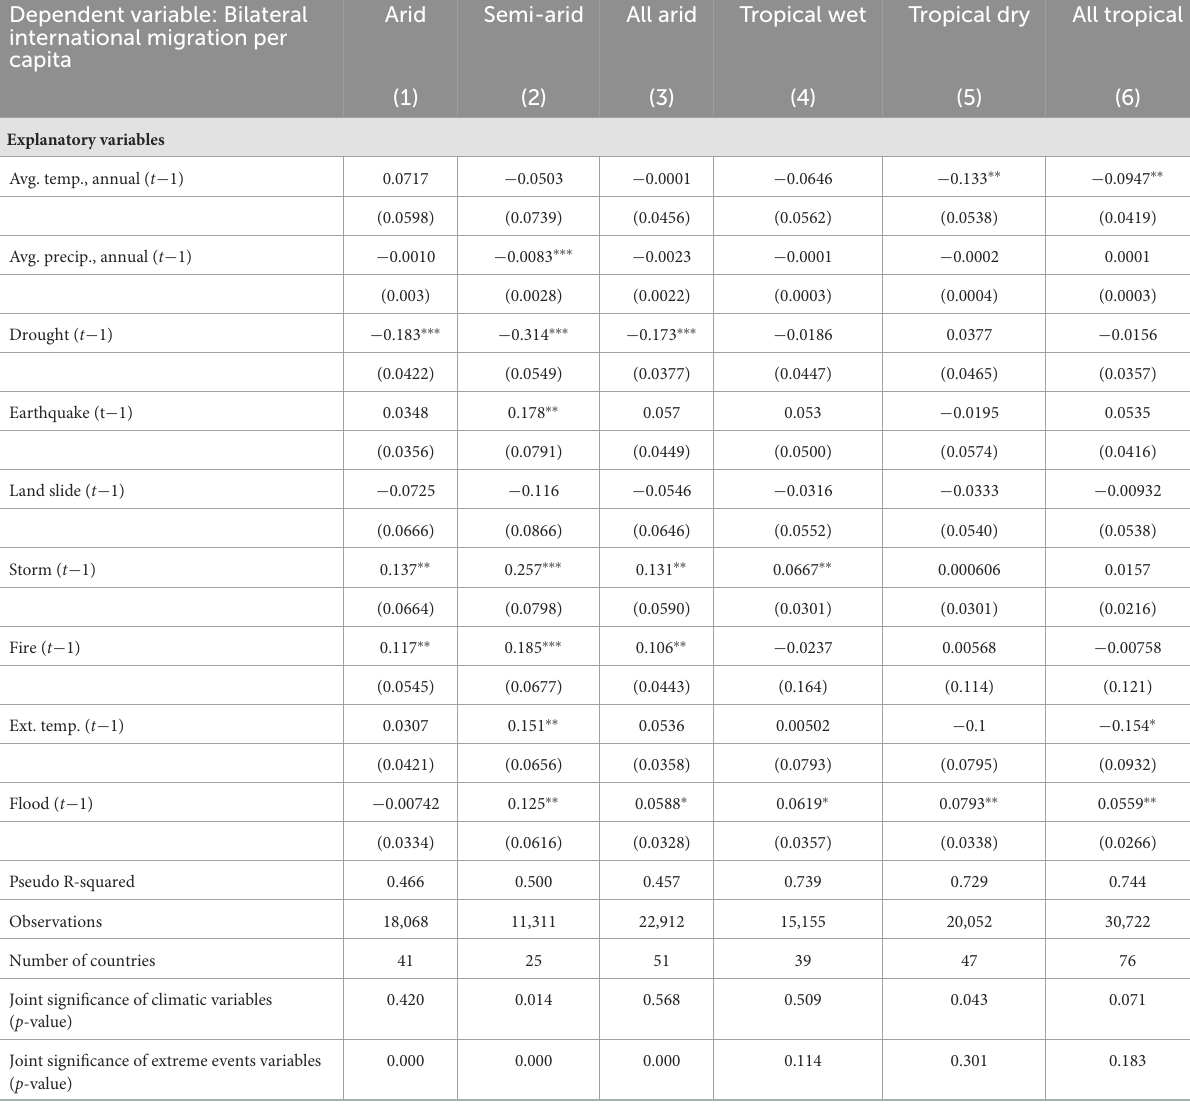
Arid Semi-arid All